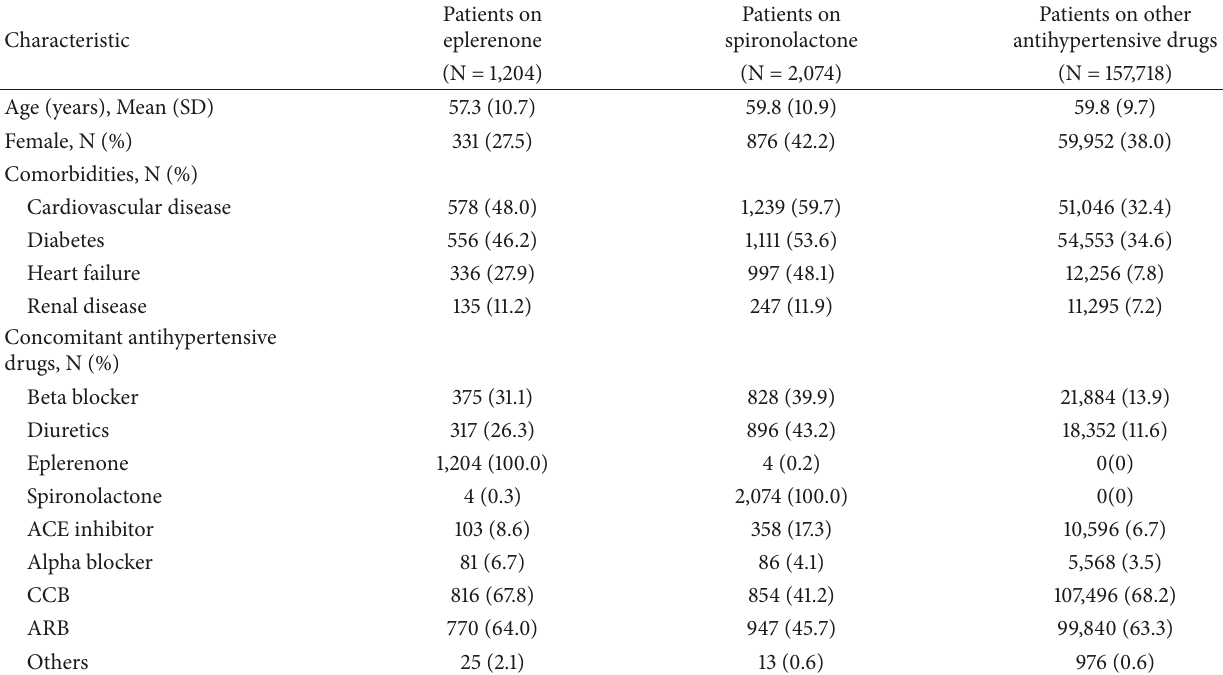
Table 1: Characteristics of the study participants: patients on eplerenone, spironolactone, or other antihypertensive drugs during the last claim month of stable treatment ( ≥ six months of treatment with the same drugs, N = 160,992 ∗ ).